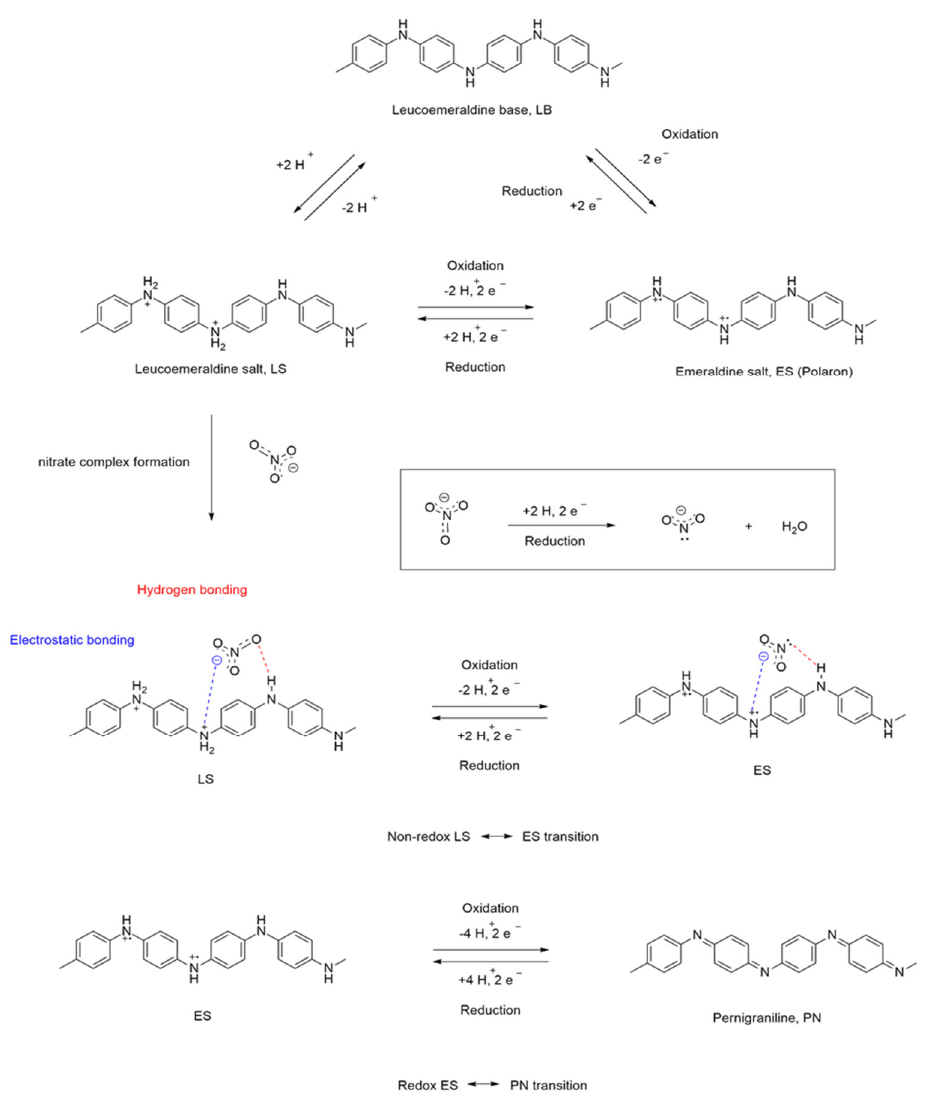
Scheme 1. Schematic representation of nitrate complex formation with LS, subsequent non-redox LS ↔ ES transition, and redox ES ↔ PS